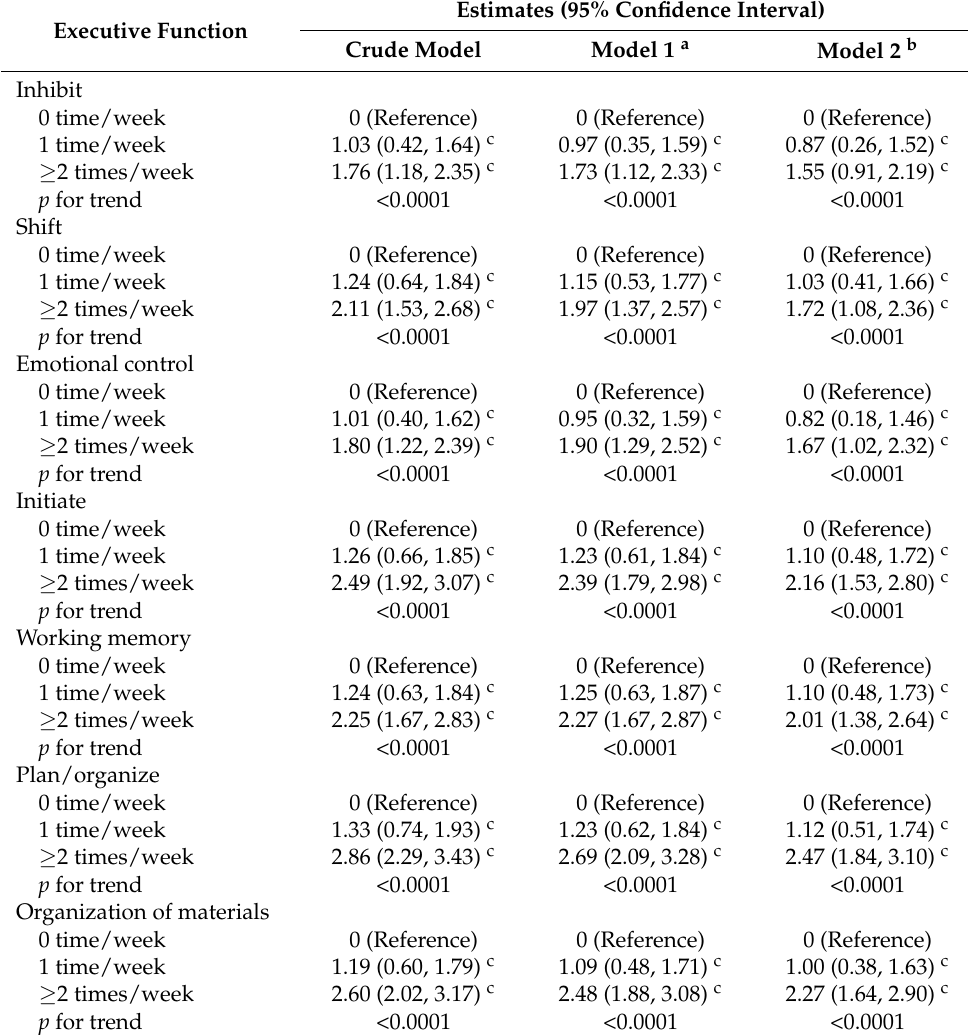
Table 2. Association between SSB consumption with executive function ( n =